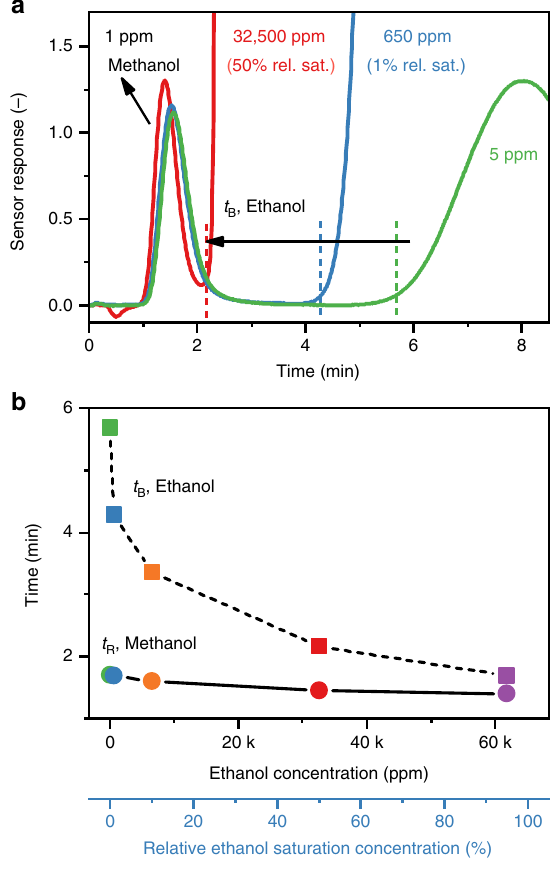
Fig. 4 Methanol detection with high ethanol interference. a Responses of the methanol detector upon exposure to 1 ppm methanol in the presence of 5 (green line), 650 (1% relative saturation, blue line), and 32,500 ppm (50% relative saturation, red line) ethanol. Corresponding ethanol breakthrough times ( t B , dashed lines) are indicated. b The ethanol t B (squares and dashed line) and methanol retention time ( t R , circles and solid line) as a function of interfering ethanol concentration of 5 (green), 650 (1% relative saturation, blue), 6500 (10% relative saturation,